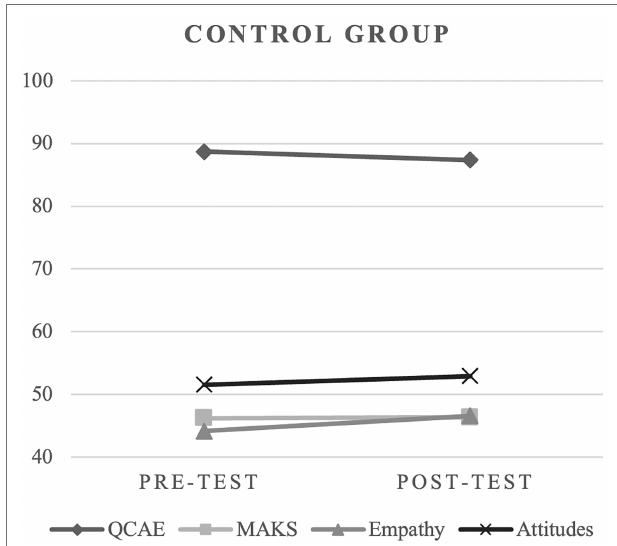
FIGURE 2 | Comparative analysis in control group.